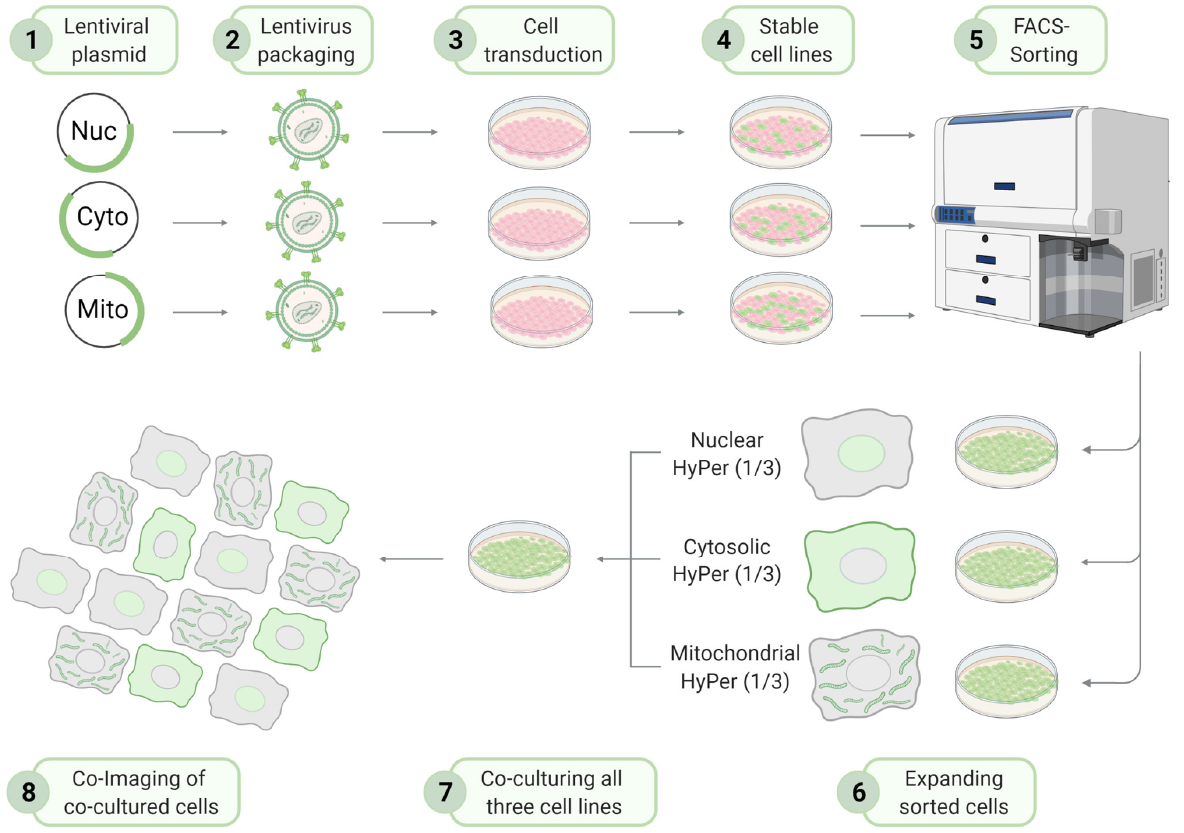
Figure 1. Schematic overview and workflow of the COMPARE IT approach. Step 1: The open reading frame of genes of interest (nuclear-, cytosolic-, and mitochondria-targeted HyPer7) are subcloned into a shuttle vector. Step 2: Lentiviral particles are generated and purified. Step 3: Native endothelial cells (EA.hy926) at low passage numbers are transduced with the respective purified lentivirus. Step 4: 48 to 72 h later, cells are further cultured and passaged for one week to allow cells to regenerate before being separated for positively transduced cells using FACS (Step 5). Step 6: Each cell line consisting of a mixture of positively transduced clones is further cultured for two more weeks or frozen for long-term storage. Step 7: For co-culture imaging, each cell line (nuclear-, cytosolic-, and mitochondria-targeted HyPer7) is seeded in a 1:1:1 ratio 24 h before imaging experiments to reach a confluency of 90% on the day of imaging. Step 8: Co-imaging of all three cell lines simultaneously using conventional fluorescence microscopy.